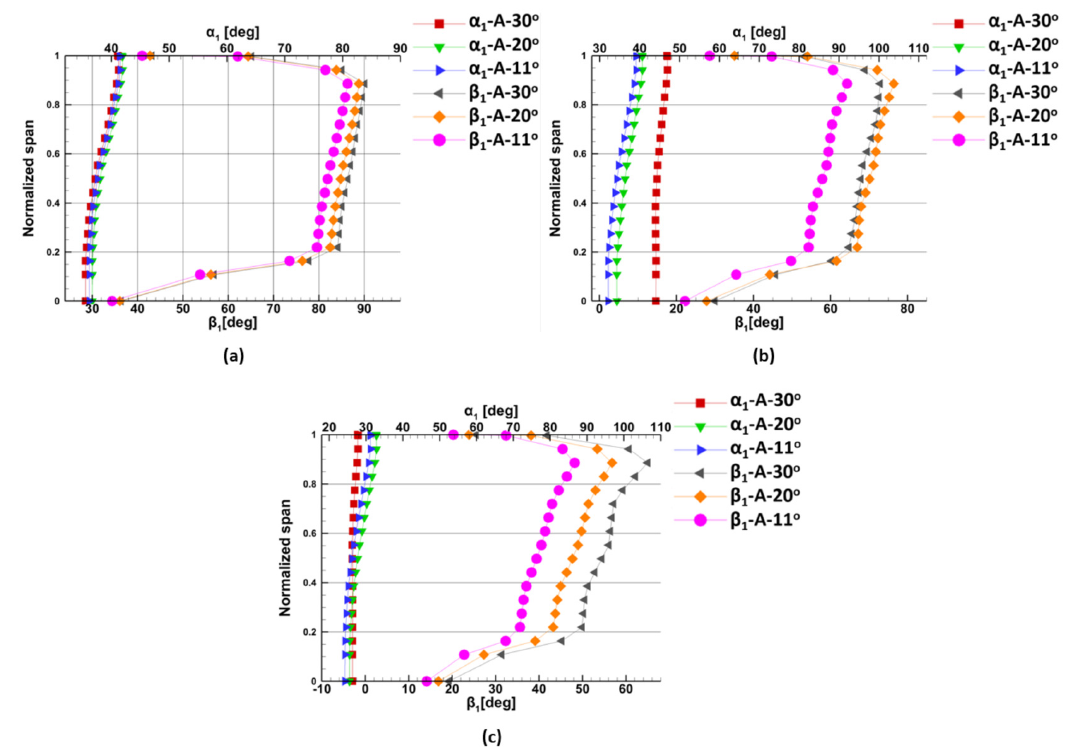
Figure 32. The plots of the absolute ( α 1 ) and relative ( β 1 ) angles measured behind the 1st stage nozzle vane against the blade height at 40,000 rpm for: ( a ) point A, ( b ) point B, ( c ) point